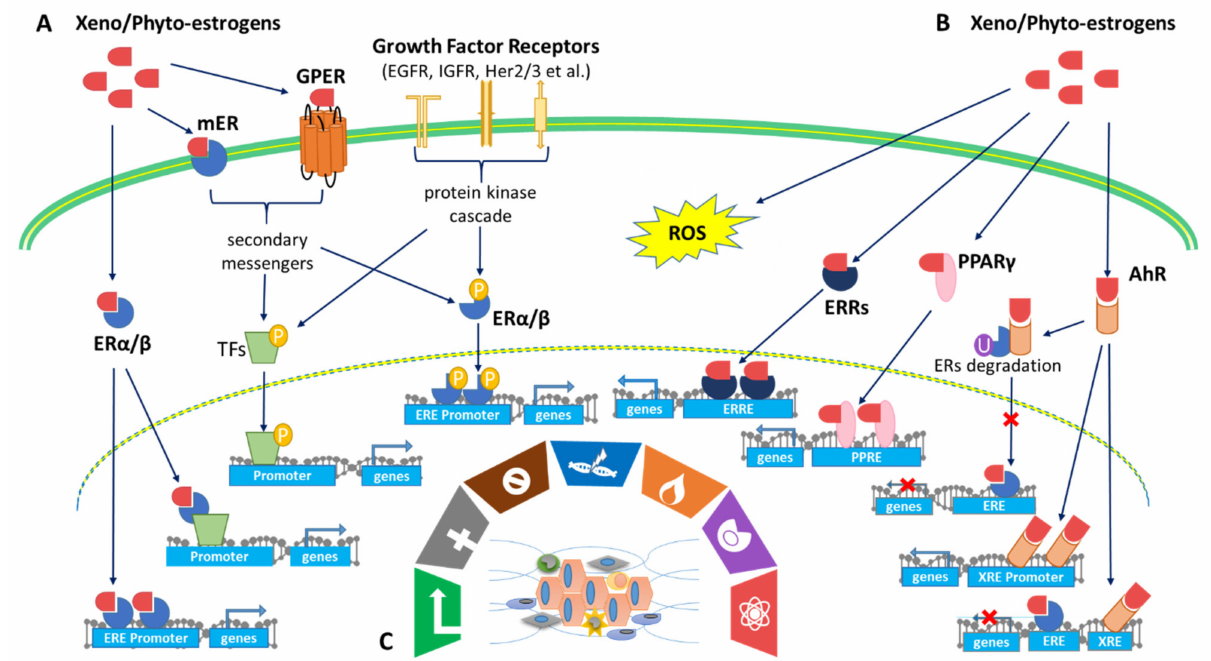
Figure 2. Xenoestrogens and phytoestrogens modulate multiple estrogen-mediated signaling pathways to shape the hallmarks of cancer. ( A ) Activation of estrogen receptor signaling. There are two types of ERs: intracellular ER α and ER β and membrane-associated mERs and GPER [157]. ERs are activated in four manners: (1) the classical genomic pathway where estrogens are bound to ERs that will activate the transcription of target genes, (2) the non-classical genomic pathway involving ERs interactions with other transcription factors (TFs) such as activator protein 1 (AP-1), including c-Fos, c-Jun, c-myc, (3) the E2-independent pathway which activates ERs through phosphorylation induced by growth factors (EGFR/IGFR/Her2/3) signaling cascades [16], and (4) the non-genomic pathway involving membrane-associated ERs such as mERs and GPER. ( B ) Co-activation of AhR/PPAR γ /ERR γ /ROS pathways. Xenoestrogens/phytoestrogens activate AhR signaling pathways and cross-talk with ER pathways: (1) AhR competes with ERs for promoter binding, leading to inhibition of ER signaling, (2) activation of AhR signaling regulates E2 production by controlling the gene expression of CYP19, also known as aromatase, and (3) activation of AhR signaling ubiquitinates ERs for degradation via the proteasome, leading to inhibition of ER signaling. Xenoestrogens/phytoestrogens activate peroxisome proliferator-activated receptors (PPARs) and estrogen-related receptor gamma (ERR γ ). Xenoestrogens/phytoestrogens could also induce oxidative stress-mediated signaling by generating reactive oxygen species (ROS). ( C ) Shaping the hallmarks of cancer. These features are linked to cell cycle and checkpoint disruption ( ), cell apoptosis and death reprogramming ( ), growth suppressor evading ), genome instability and mutation ( ), tumor inflammation-promoting ( ), immune response